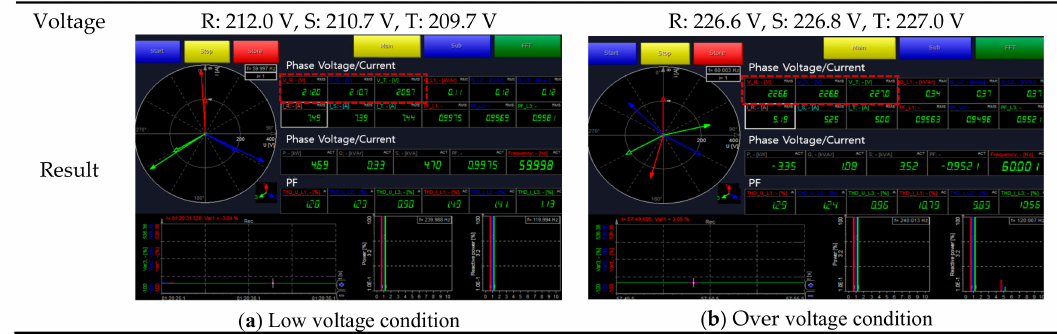
Figure 24. Test results of the customer voltage characteristic by ESS and SVR (assumed)